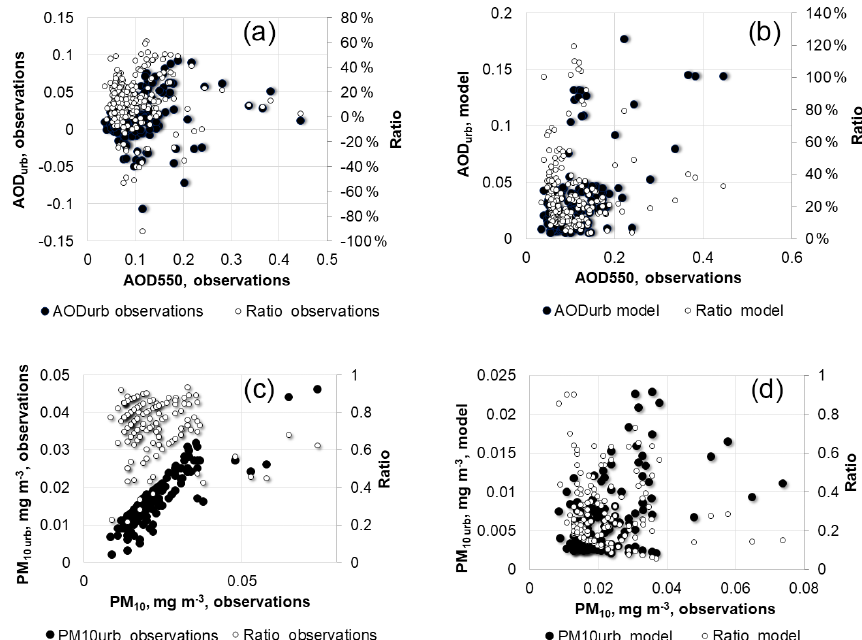
Figure 10. Measured (a, c) and model (b, d) urban component of aerosol optical depth at 550nm (AOD urb ), urban PM 10 mass concentration (PM 10urb , mgm − 3 ) and their ratios to the observed total AOD550 and PM 10 as a function of the observed total AOD550 (a, b) and PM 10 (c, d) in Moscow (MSU MO). For consistency reasons, we show only quasi-simultaneous AOD and PM 10 measurements during the daytime period with AOD observations. The cases affected by biomass burning aerosol were excluded.